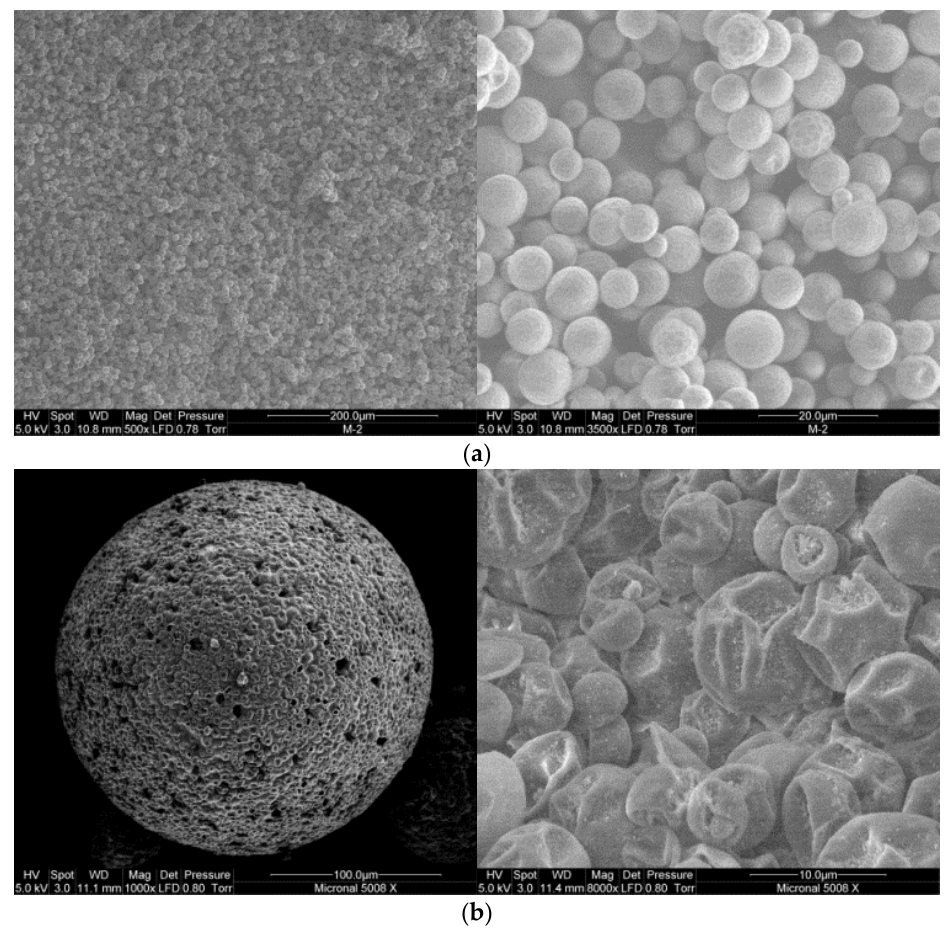
Figure 2. SEM images for the studied samples: ( a ) M ‐ 2 (magnification: ×500 left and ×3500 right); ( b ) Micronal ® DS 5008 X (magnification: ×1000 left and ×8000 right).